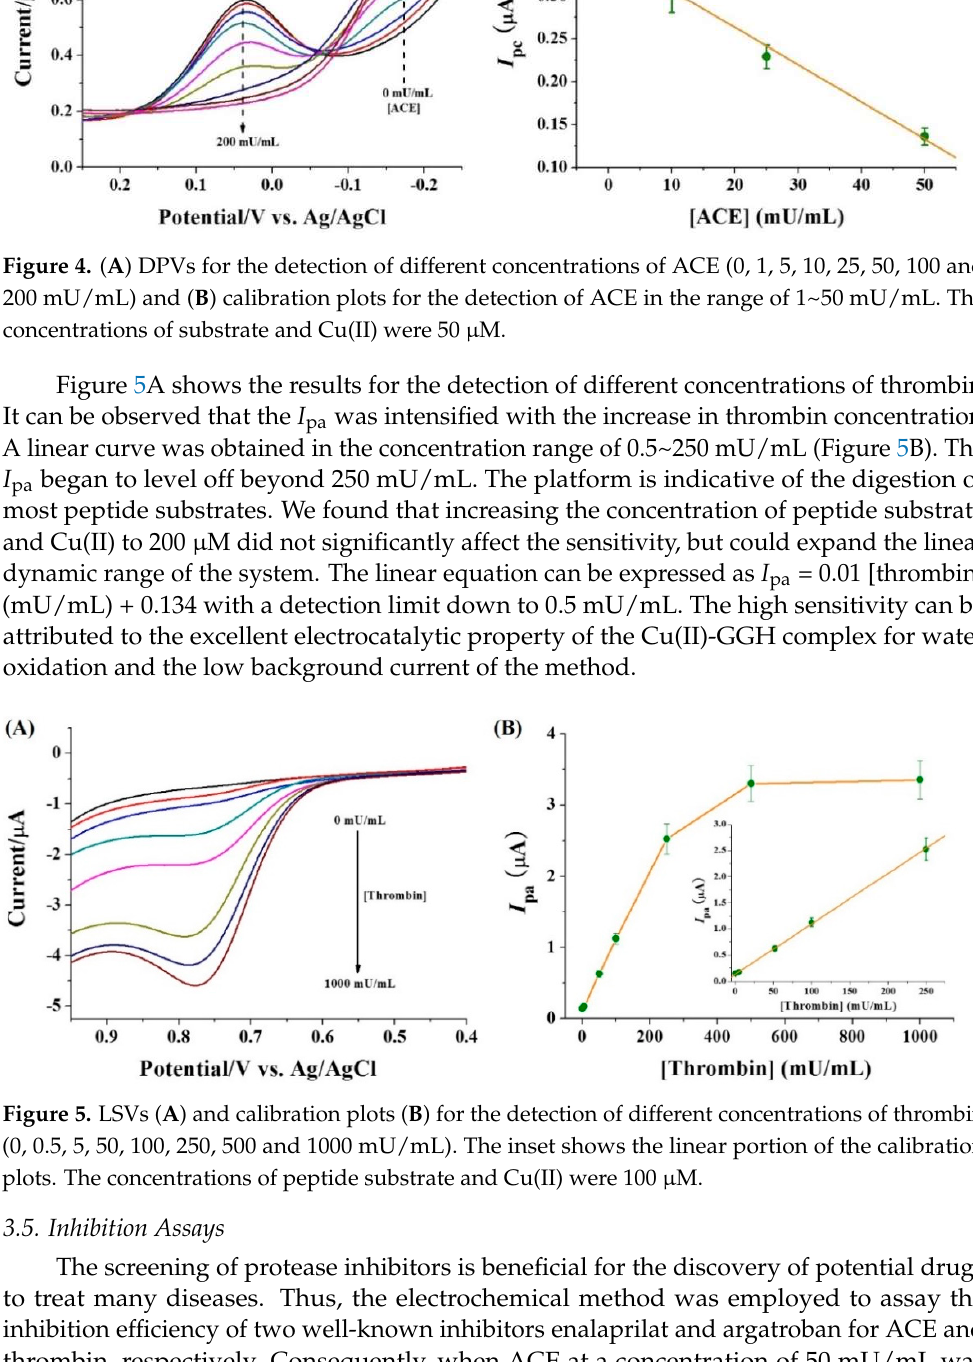
Figure 5. LSVs ( A ) and calibration plots ( B ) for the detection of different concentrations of thrombin (0, 0.5, 5, 50, 100, 250, 500 and 1000 mU/mL). The inset shows the linear portion of the calibration plots. The concentrations of peptide substrate and Cu(II) were 100 μ M.